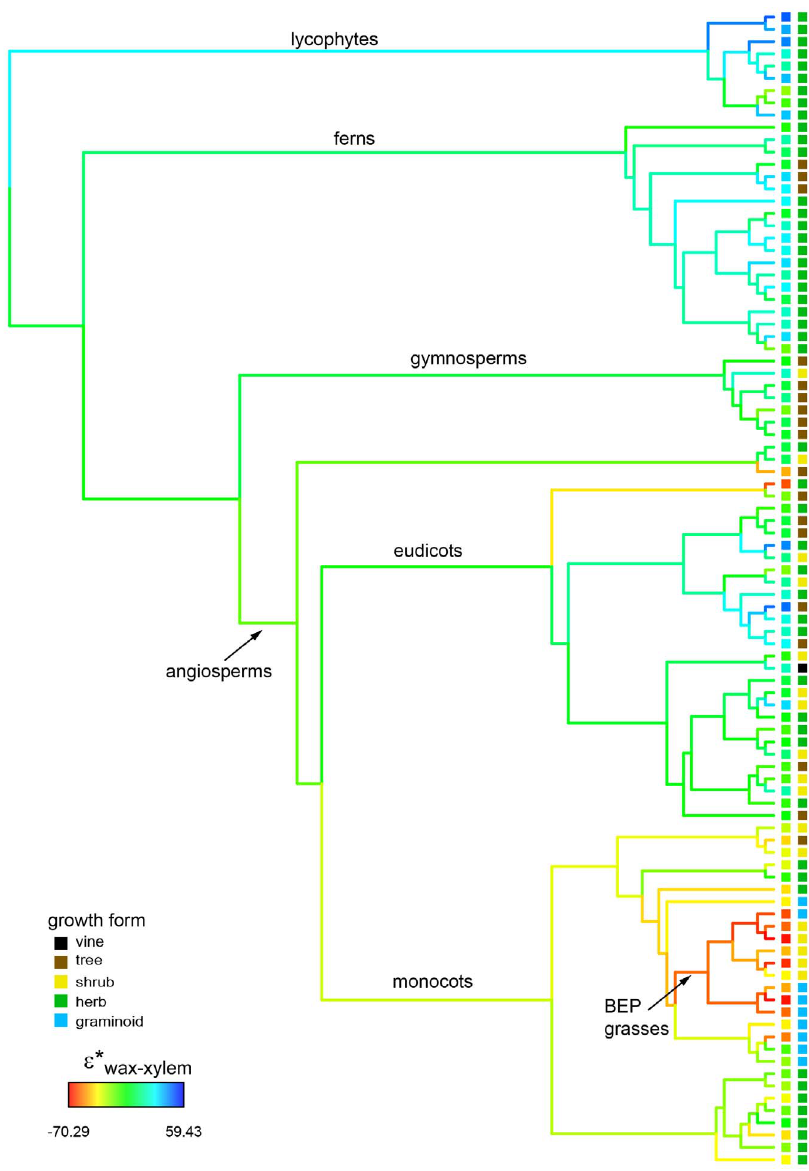
Figure 2. Phylogenetic patterns of mean leaf wax hydrogen isotope fractionation values of n -alkanoic acids. The tip values are the combined scaled values based on measurements of collected modern species (as in Fig. 1). The left of the two columns represent the living species values of e * wax-xylem-acid , and colored branches represent inferred ancestral values. The right column represents different growth forms.